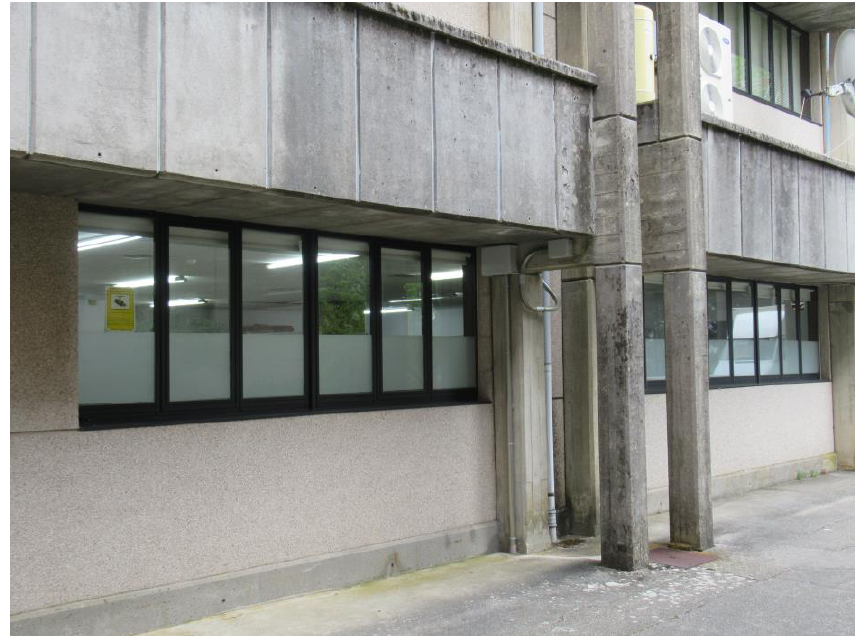
Figure 7. Identification of the different propagation contributions in the delay domain.